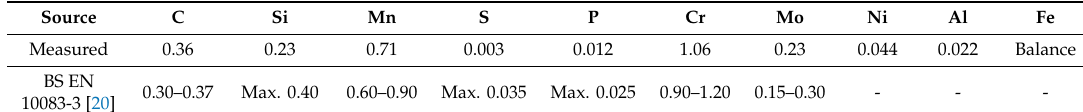
Table 1. Chemical composition of 34CrMo4 steel (%, mass fraction).